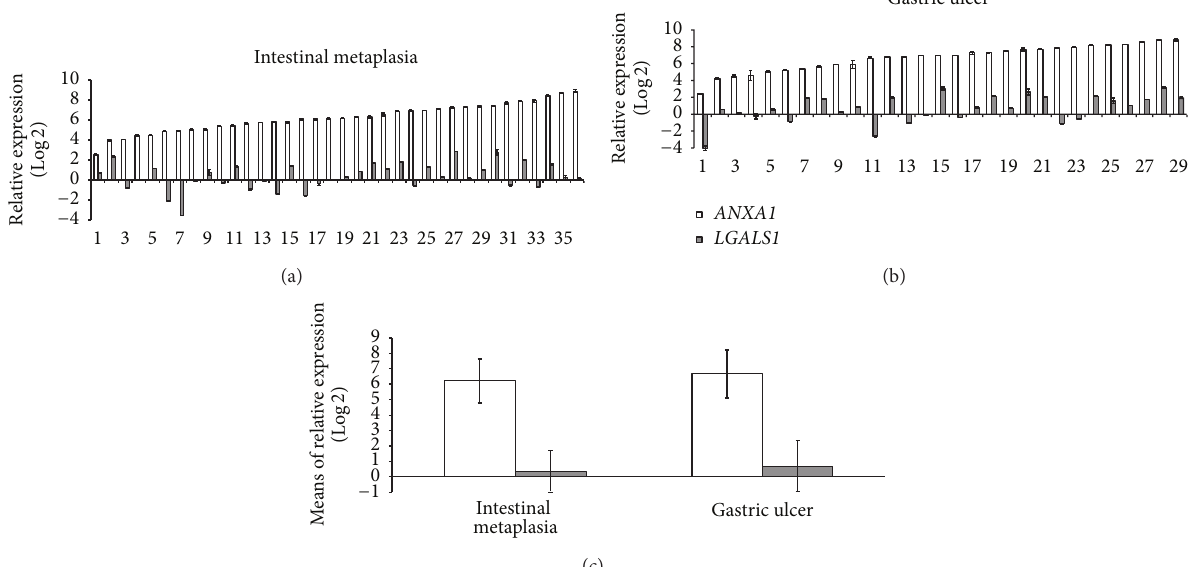
Figure 1: Distribution of relative gene expression (Log2RQ) of ANXA1 and LGALS1 (a and b) and mean values of relative gene expression in intestinal metaplasia and gastric ulcer groups